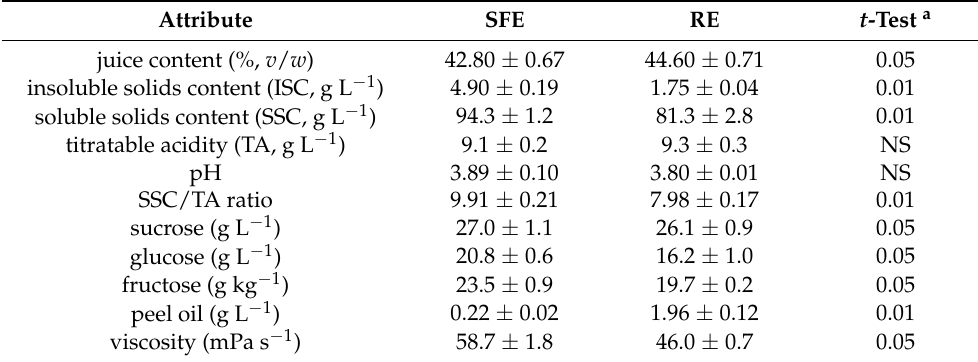
Table 1. Effect of shear force extractor (SFE) and reamer extractor (RE) type on basic juice properties: juice content, insoluble solids content (ISC), soluble solids content (SSC), titratable acids (TA),